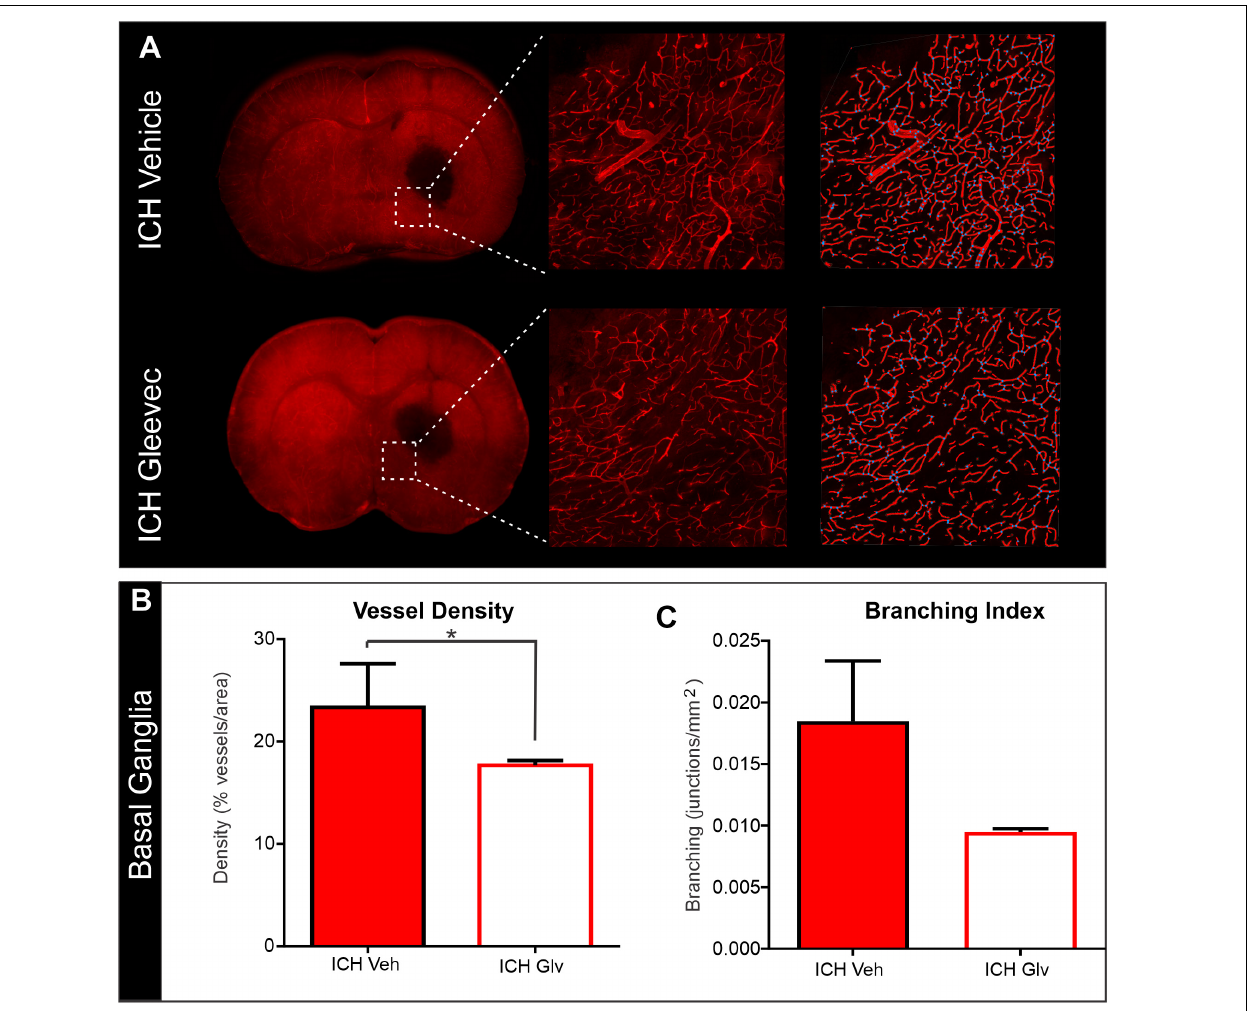
FIGURE 6 | Confocal analysis of the basal ganglia vasculature revealed no improvement with Gleevec treatment. (A) The basal ganglia vasculature was assessed for morphological characteristics adjacent to the ICH site. As in the cortex, there was reduced vascular density with loss of fine vascular structures, including branch points. Far right pane illustrates the analysis that derived vessel density (red) and branching (blue dots). (B) Quantification of vascular metrics confirmed the visual observations with significantly reduced vascular density ( p = 0.05) and trending decreases in (C) vessel branching ( p = 0.09) in Gleevec treated compared to Vehicle treated